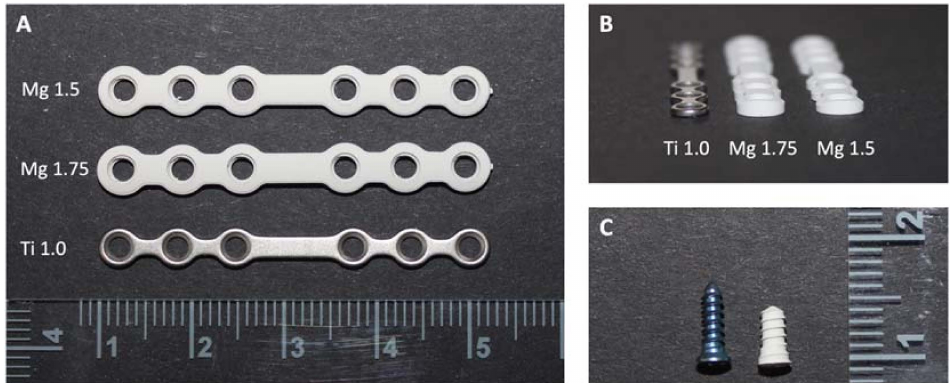
Figure 1. ( A ) Comparison of the different miniplates. All plates had the same number of holes and the same length. Magnesium miniplates were wider, and, within the screw holes, the thread for the locking screws was visible. ( B ) Comparison of the plate profiles. In comparison to the titanium miniplate with a thickness of 1.0 mm, the magnesium miniplates had greater volume. ( C ) Titanium screw (blue, left) 2.0 mm in diameter and 7 mm in length and magnesium screw (white, right) 2.3 mm in diameter and 5 mm in length. The same screw diameter and length were used for both plate thicknesses in